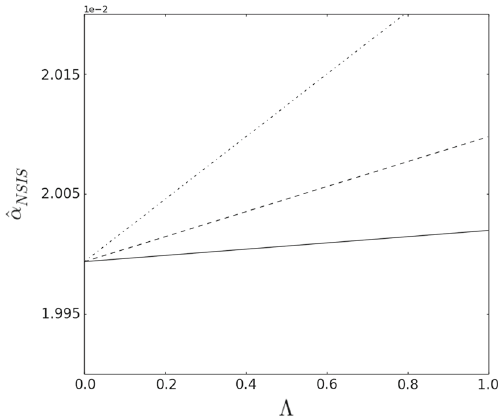
Fig. 10 Plot of ˆ α NSIS vs. (cid:22) J r for Λ = 1 (continuous line), Λ = 0 . 25 (dashed line), and Λ = 0 . 1 (dot-dashed line). We used, b = 100, r c = 10, sin χ = 1, and ω 2 c /ω 2 = 0 . 5. Note the scale used for the deflection angle: each value is multiplied by 1 e − 2 = 1 × 10 −